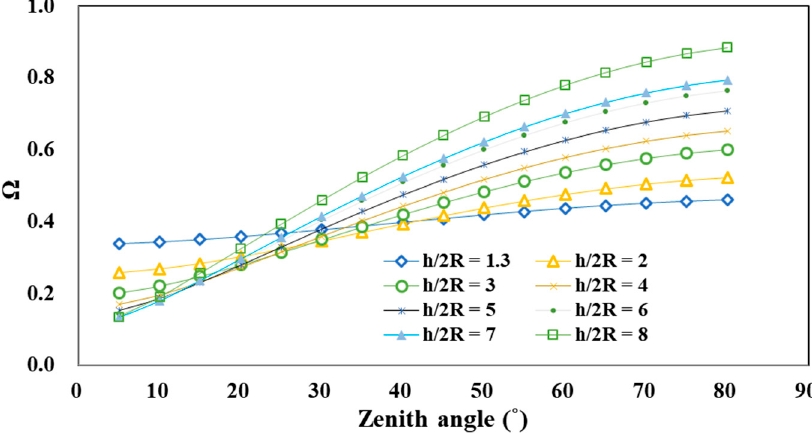
Figure 17. Clumping index variation with zenith angle for different tree trunk heights. Simulation parameters as shown in Table 2, column 5.